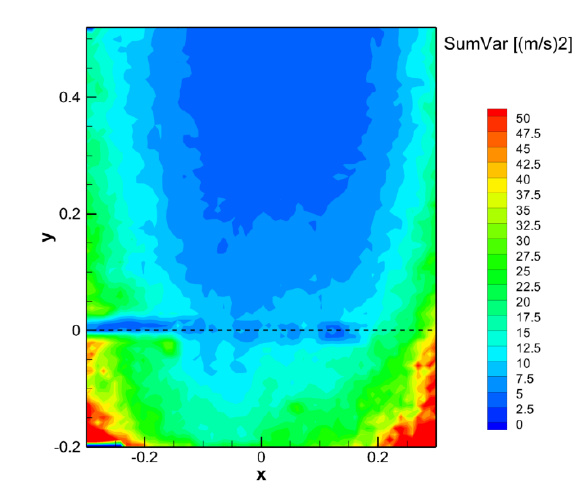
Fig. 12. Sum of velocity components variances. Re =